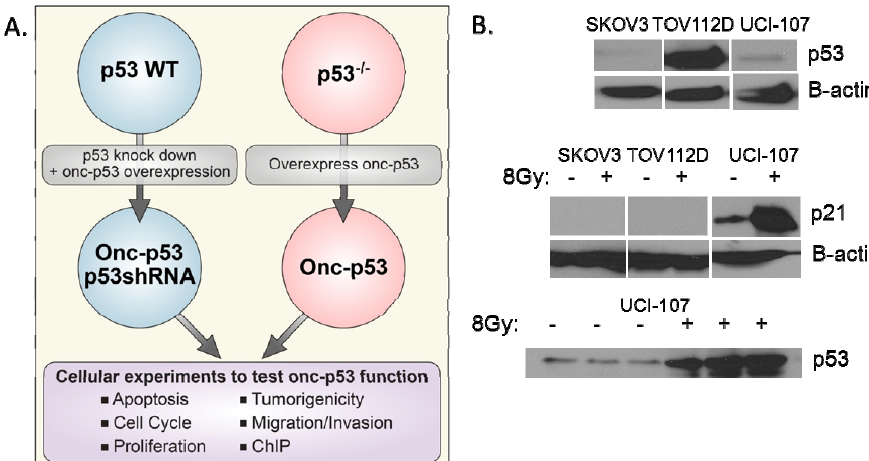
Figure 3. Proposed strategies for uncovering oncomorphic p53 functions: ( a ) Example of an experimental outline used to understand the function of specific TP53 mutants. Two cellular models are employed: ( 1 ) In cells containing WT p53, an shRNA can be stably expressed to knock down endogenous p53, while simultaneously overexpressing an shRNA-resistant oncomorphic p53 mutant; ( 2 ) Cells with LOF TP53 mutations that do not produce a p53 protein can be used to overexpress oncomorphic p53 variants. Both of these models can then be used to examine the effect of each p53 mutant compared to control cells; ( b ) Example of identifying endogenous p53 function in various ovarian cancer cell lines. Top panel, baseline p53 expression in SKOV3 cells ( LOF TP53 , nonsense mutation), TOV112D (oncomorphic p53, R175H), and UCI-107 cells (WT p53). Middle panel, expression of p21, a marker of WT p53 activation, was assessed 10 h after 8 Gy radiation-induced DNA damage. Bottom panel, stabilization of p53 expression was demonstrated 10 h after